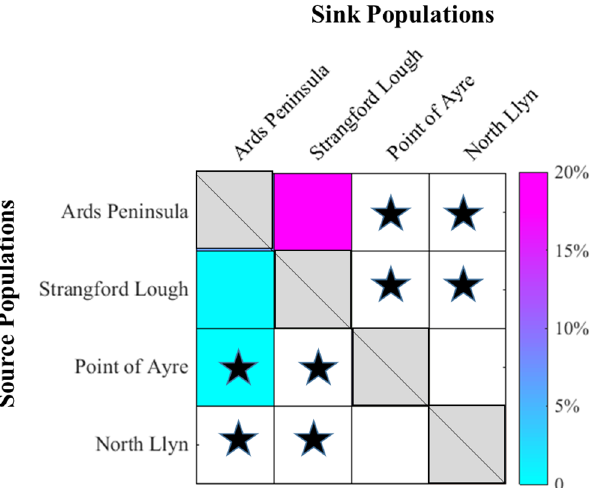
Fig 6. Connectivity matrix aligning larval dispersal and genetic differentiation. Blacks stars represent significant differentiation. Diagonal cells signify retention at the release sites, and coloured cells elsewhere signify directional connectivity. White cells signify no